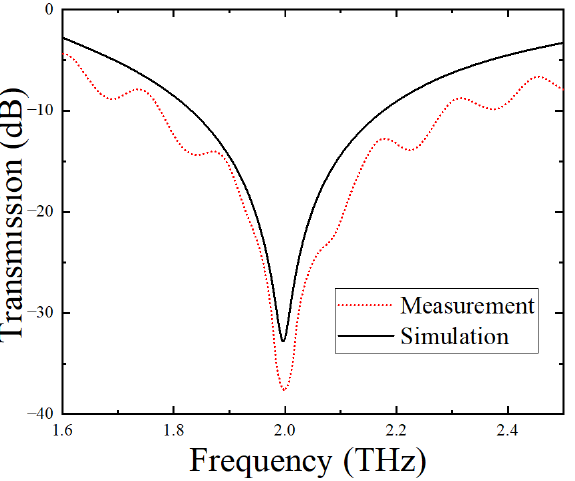
Figure 5. Measured and simulated THz transmission spectra of the blank sensor without analytes.